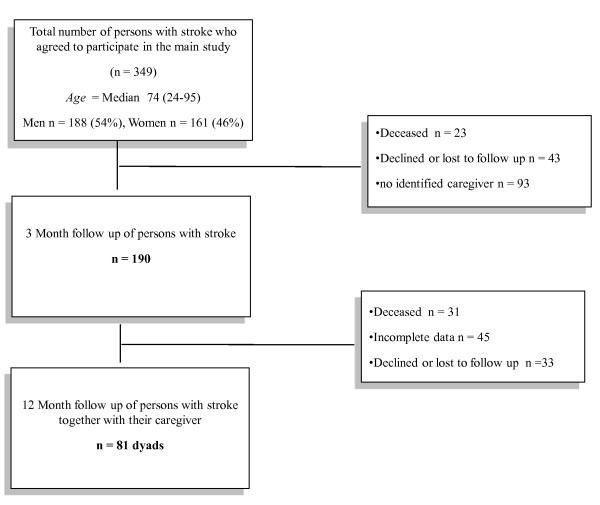
Study Participants.